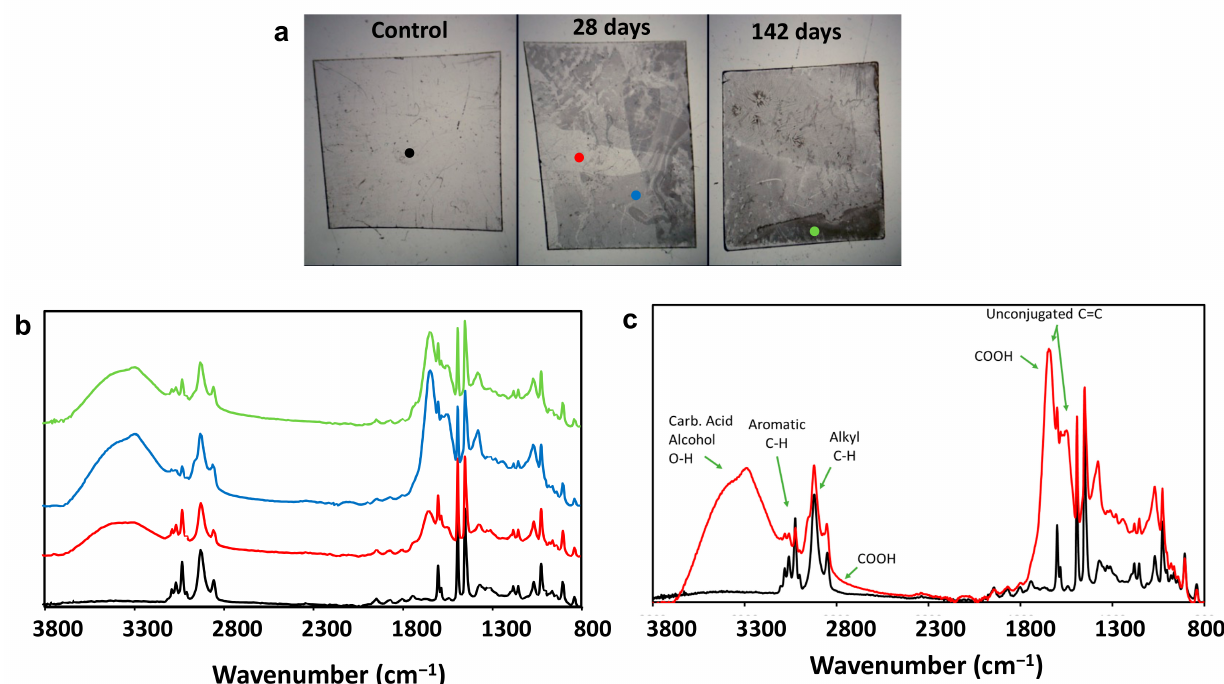
Figure 6. ATR-FTIR analysis of PS degradation after exposure to Exiguobacterium sp. RIT 594 for different periods of time. ( a ) Pictures of PS in culture media for 28 days (left) and exposed to the bacterium for either 28 (middle) or 142 (right) days. Color dots represent where ATR-FTIR spectra were obtained. ( b , c ) ATR-FTIR spectra of PS after different exposures. ( b ) The spectrum colors correspond to the colored points shown in panel A. PS in the control shows no degradation, being identical to pristine PS. Spectra of PS exposed to the bacterium indicate that the biotransformation oc- curring in styrene involves the addition of both hydroxyl and carboxylic acid functional groups to the benzyl ring. ( c ) Assignment of additional IR peaks from the degradation of PS by Exiguobacterium sp. RIT 594 (red traces) compared to the control sample (black traces) after 28 days of bacterial